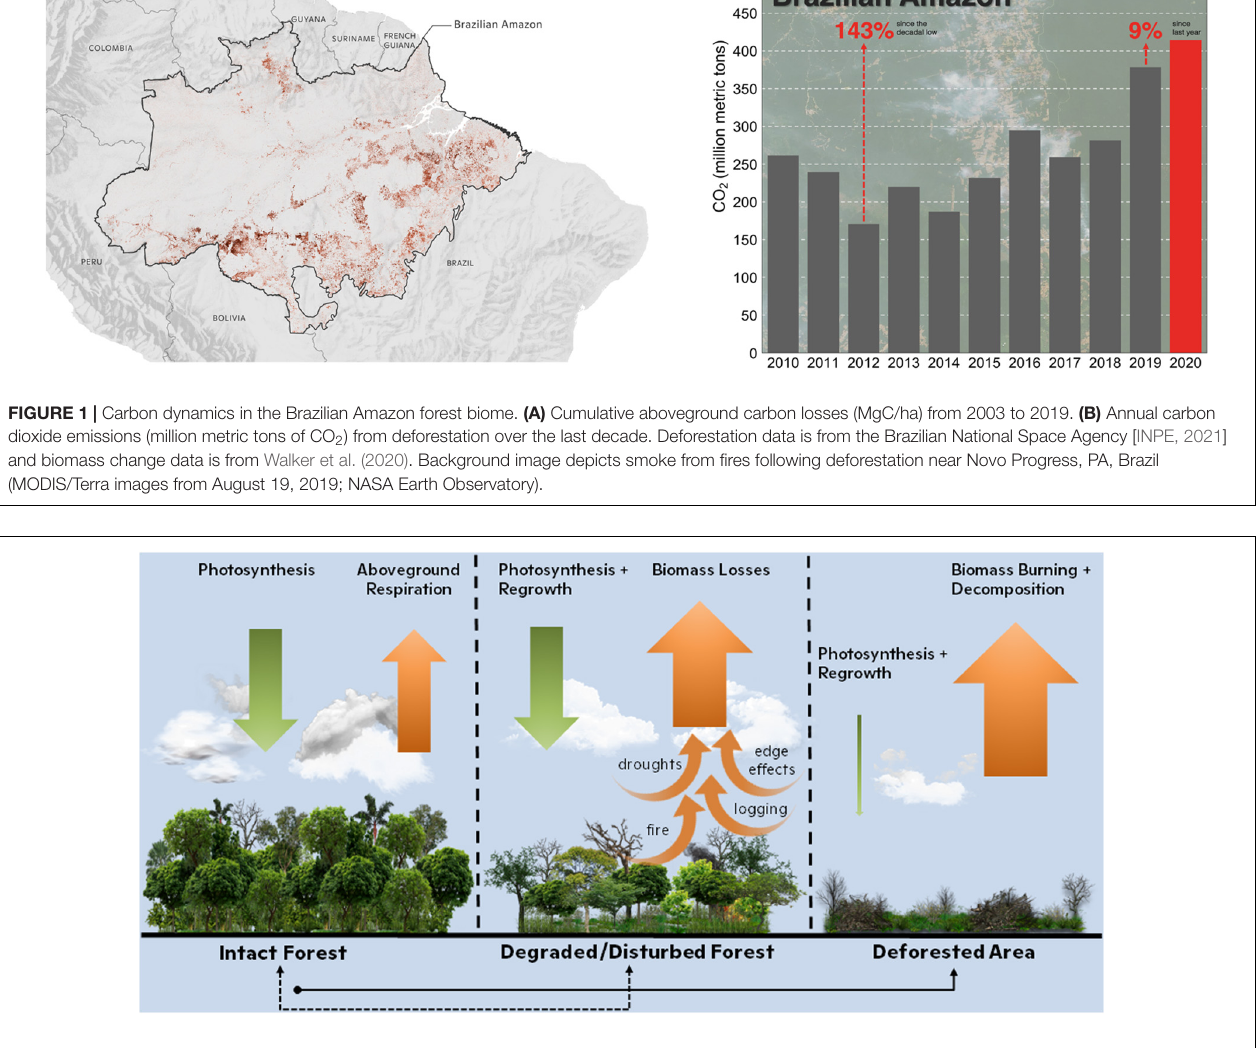
FIGURE 2 | Conceptual diagram showing above-ground carbon fluxes typical of healthy forests (left), degraded/disturbed forests (middle), and newly deforested areas (right) in the Amazon. In each panel, carbon stocks are represented by the standing vegetation, losses by the orange upward arrows, and gains by the green downward arrows. Sources contributing to degradation and disturbance include direct (logging, fire) and indirect (droughts, edge effects) anthropogenic drivers. The one-way, solid black arrow represents forest clearing (deforestation) and conversion to another land use/cover— once deforested, these areas are unlikely to regenerate to an intact forest. The two-way, dashed line reflects degradation/disturbance of intact forests. Depending on the intensity and frequency of disturbances, degraded/disturbed forests may regenerate into intact